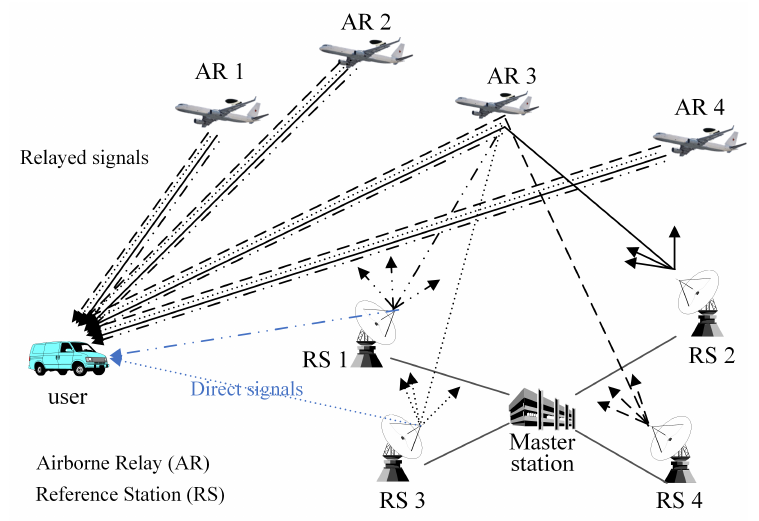
Figure 1. Configuration of the airborne relay-based positioning